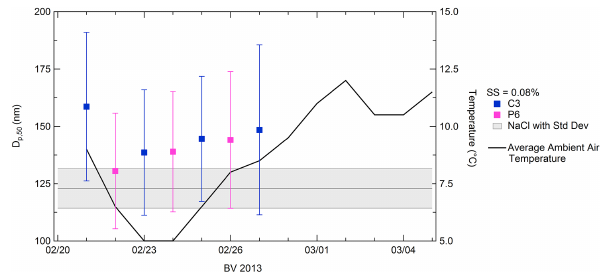
Figure 6. Activation diameter and ambient air temperatures for BV. Data are shown for SS = 0.08% (dT3). The shaded bar indicates the NaCl activation